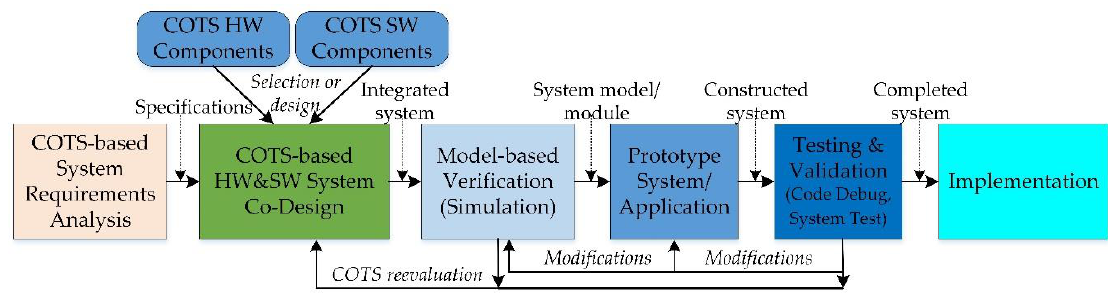
Figure 4. Commercial off-the-shelf (COTS)-based system development process.